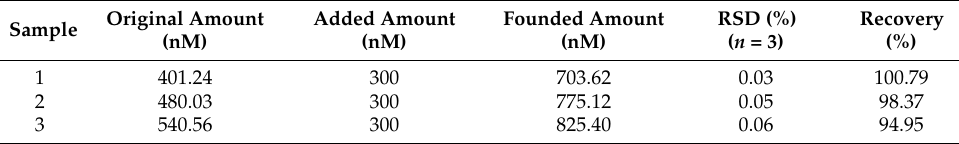
Table 2. Recovery results for PPi detection in human urine samples.